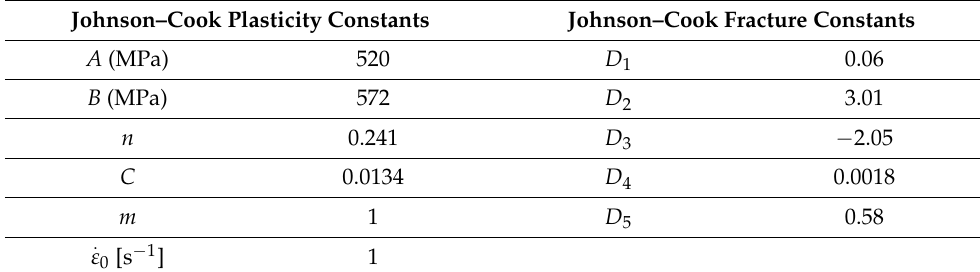
Table 9. Johnson – Cook constants for the AISI1045. Table 9. Johnson–Cook constants for the AISI1045.